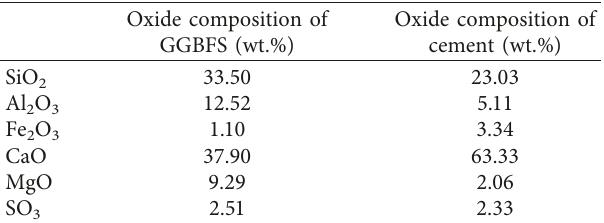
Figure 2: SEM images of slag powder at different wet grinding times: (a) raw slag and wet grinding for (b) 20 min, (c) 40min, and (d) Table 2: Chemical composition of GGBFS and cement.